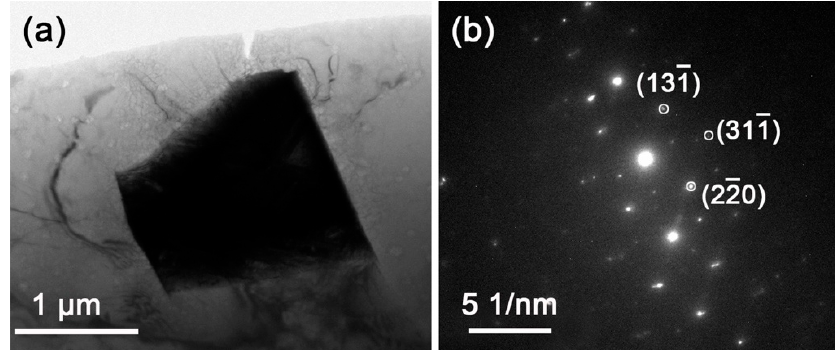
Figure 6. ( a ) TEM image of the Mg–Al–Gd alloy quenched under 1 T, and ( b ) selected area electron diffraction (SAED) pattern of the black particle in (a).